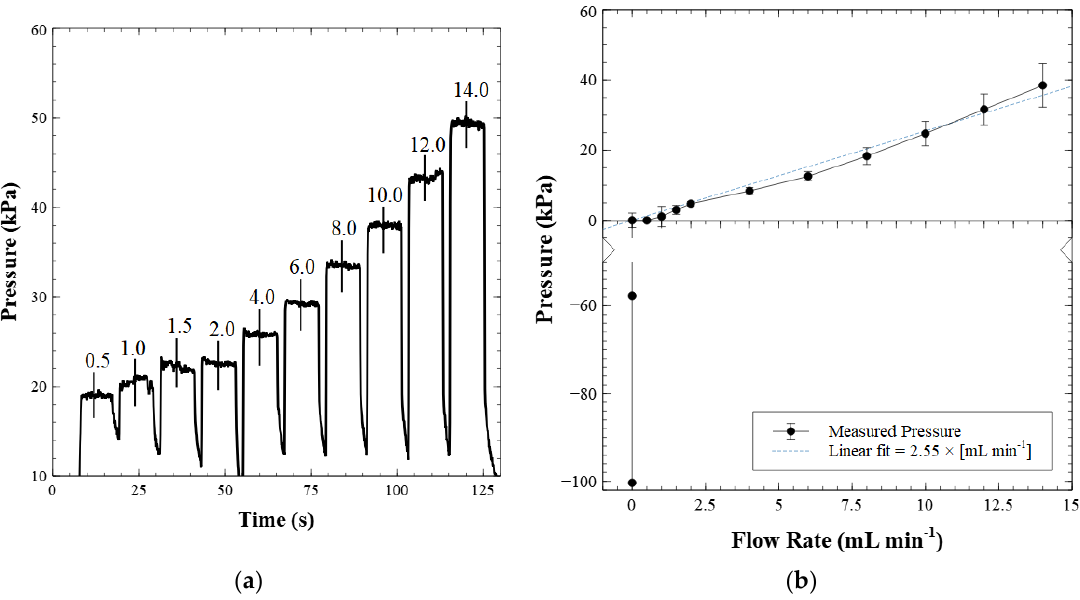
Figure 6. ( a ) Forward flow characterization. Fluid is injected into the valve inlet at set flow rates as labeled (mL min −1 ) in 10 s intervals. The pressures corresponding to each flow rate are measured as the average of each plateau, with the standard deviation about the average used as the experimental error; ( b ) characterization curve of the valve. The cracking pressure of the valve is subtracted from each measurement. The displayed error is the standard deviation from the results of six different test